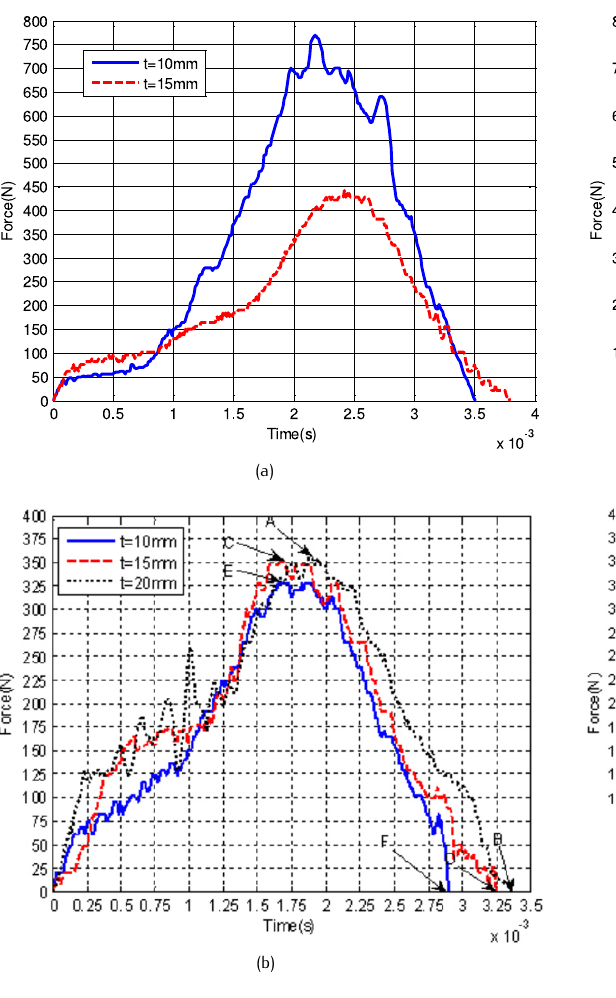
Figure 14. Contact force versus displacement for crushable foams: (a) PUR; (b)